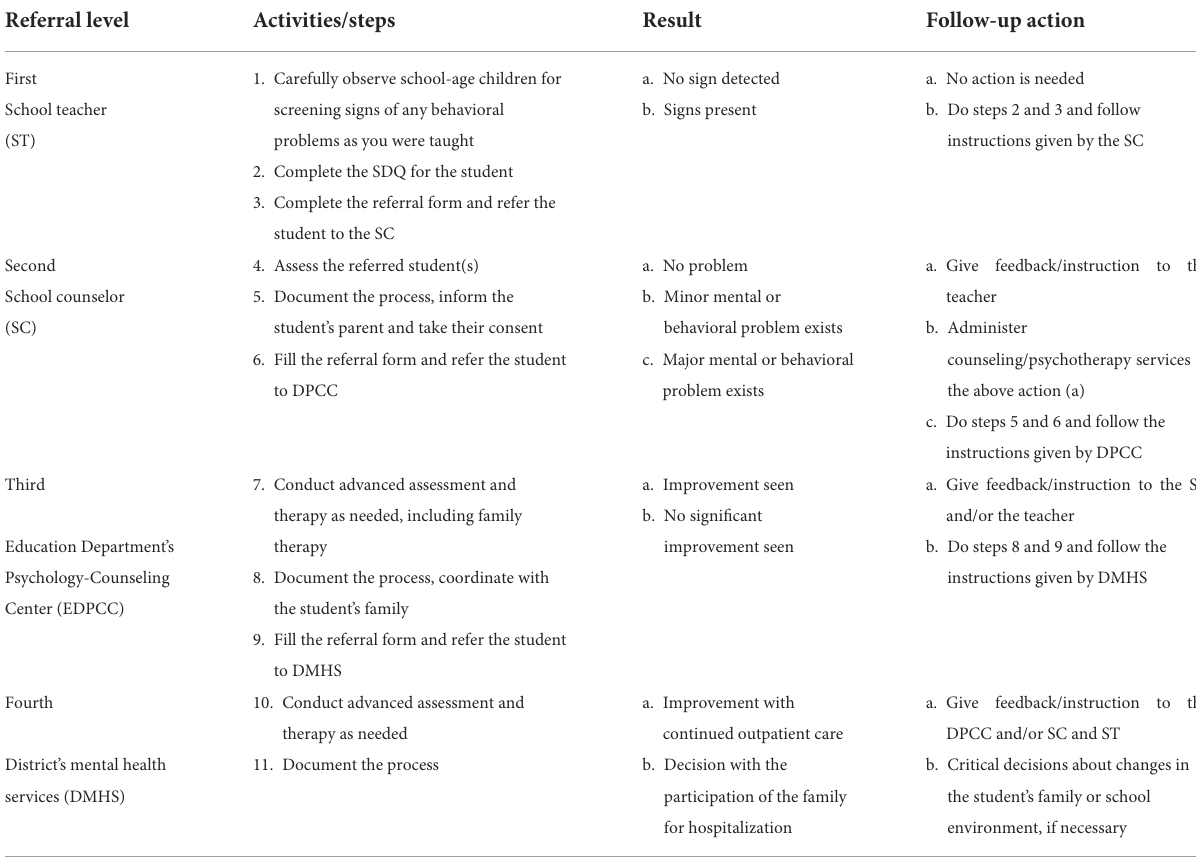
TABLE 1 School-based Mental Health Promotion. Process of psychological care/services including steps and activities in terms of referral levels. Referral level Activities/steps